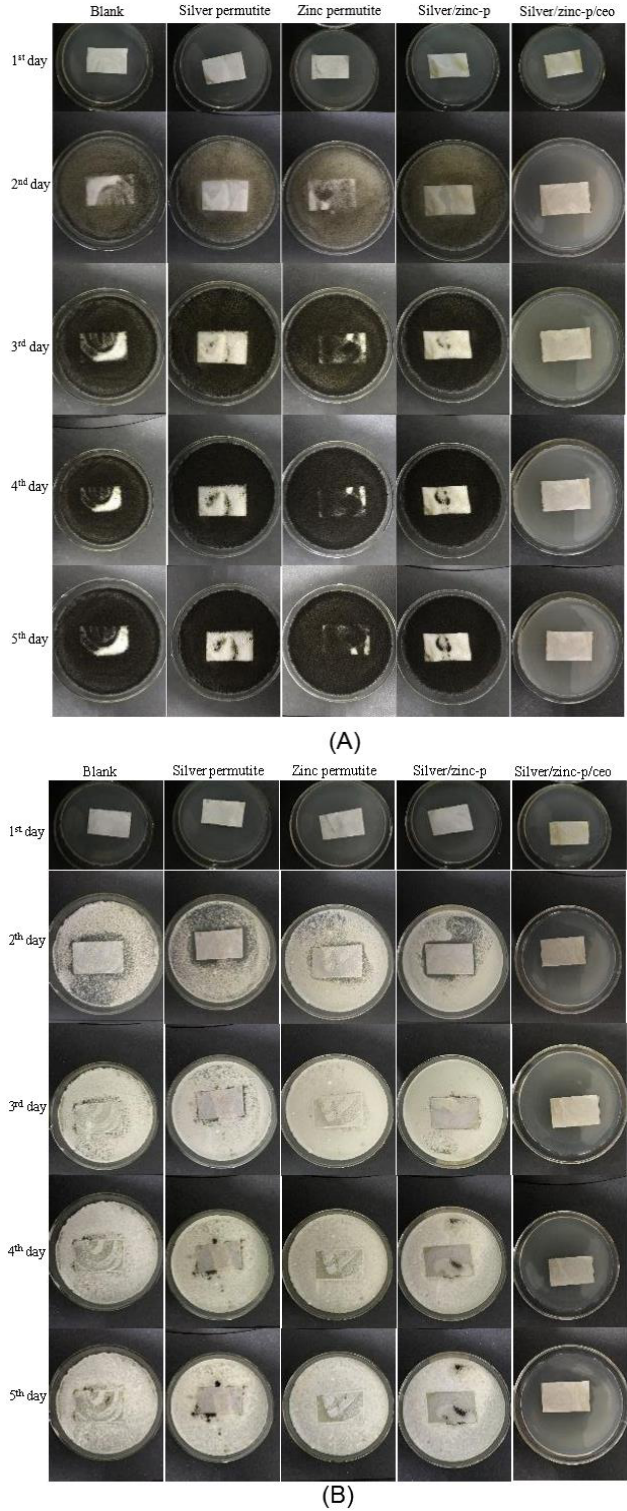
Figure 6. Antimicrobial activity assays against ( A ) Aspergillus niger and ( B ) Penicillium.